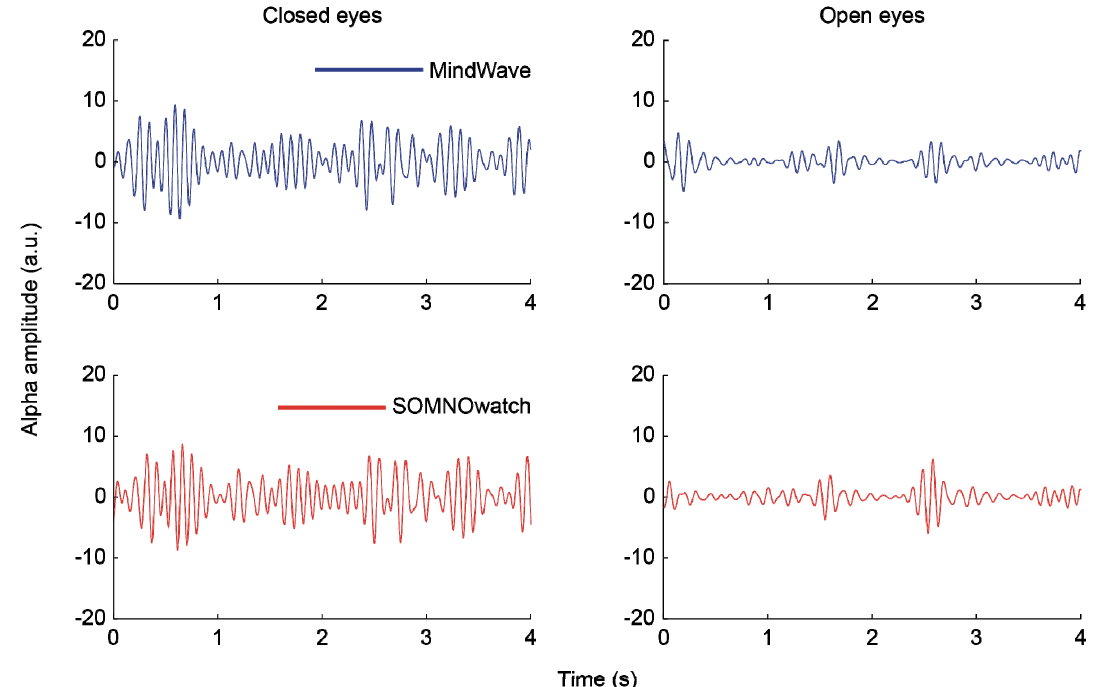
Figure 8. Normalized alpha waves as simultaneously captured by both devices during periods of closed eyes and open eyes. Alpha waves were separated from the rest of the signal using a 10th-order Chebychev filter. The alpha amplitude is clearly increased in closed eyes periods. Table 1. A summary of statistical results comparing recording and reference sites (1), similarity (2),